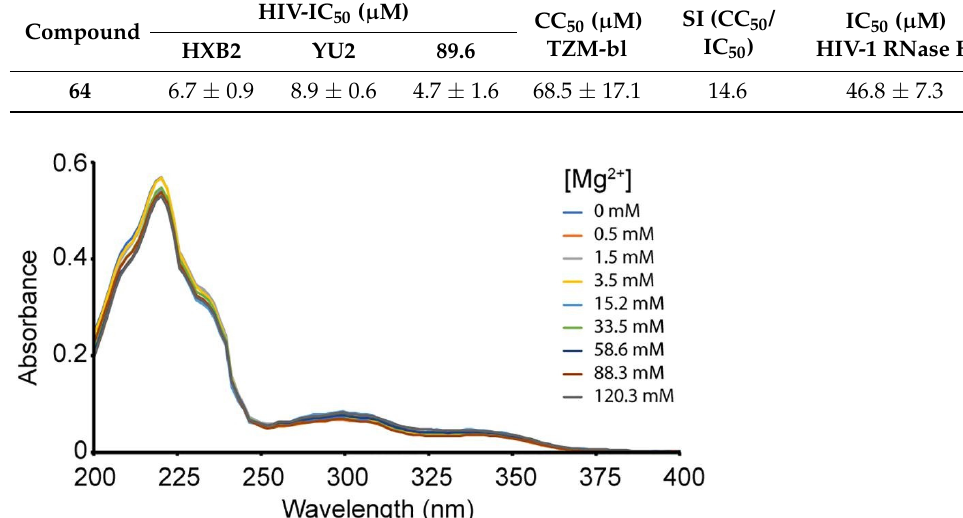
Table 9. The inhibitory activity of compound 64 against different HIV strains and HIV-1 RNase H. Compound